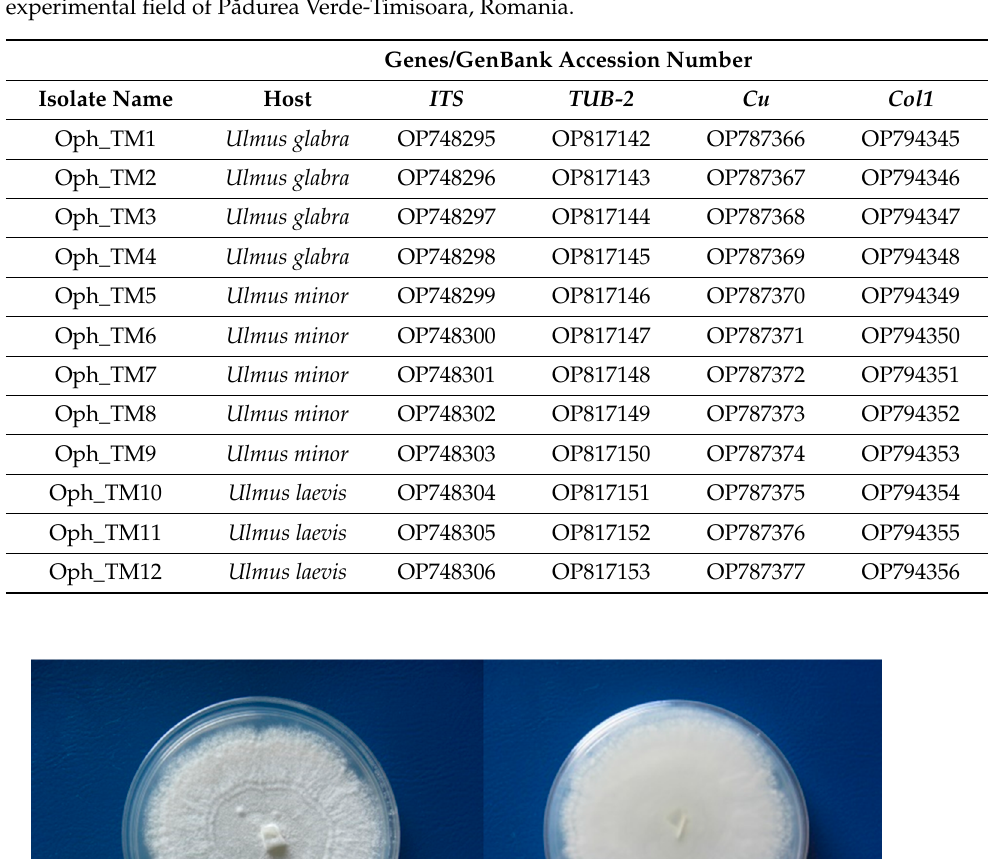
Table 2. Fungal isolates of O . novo-ulmi obtained in this study from four Ulmus species located in the experimental field of P ă durea Verde—Timisoara, Romania.